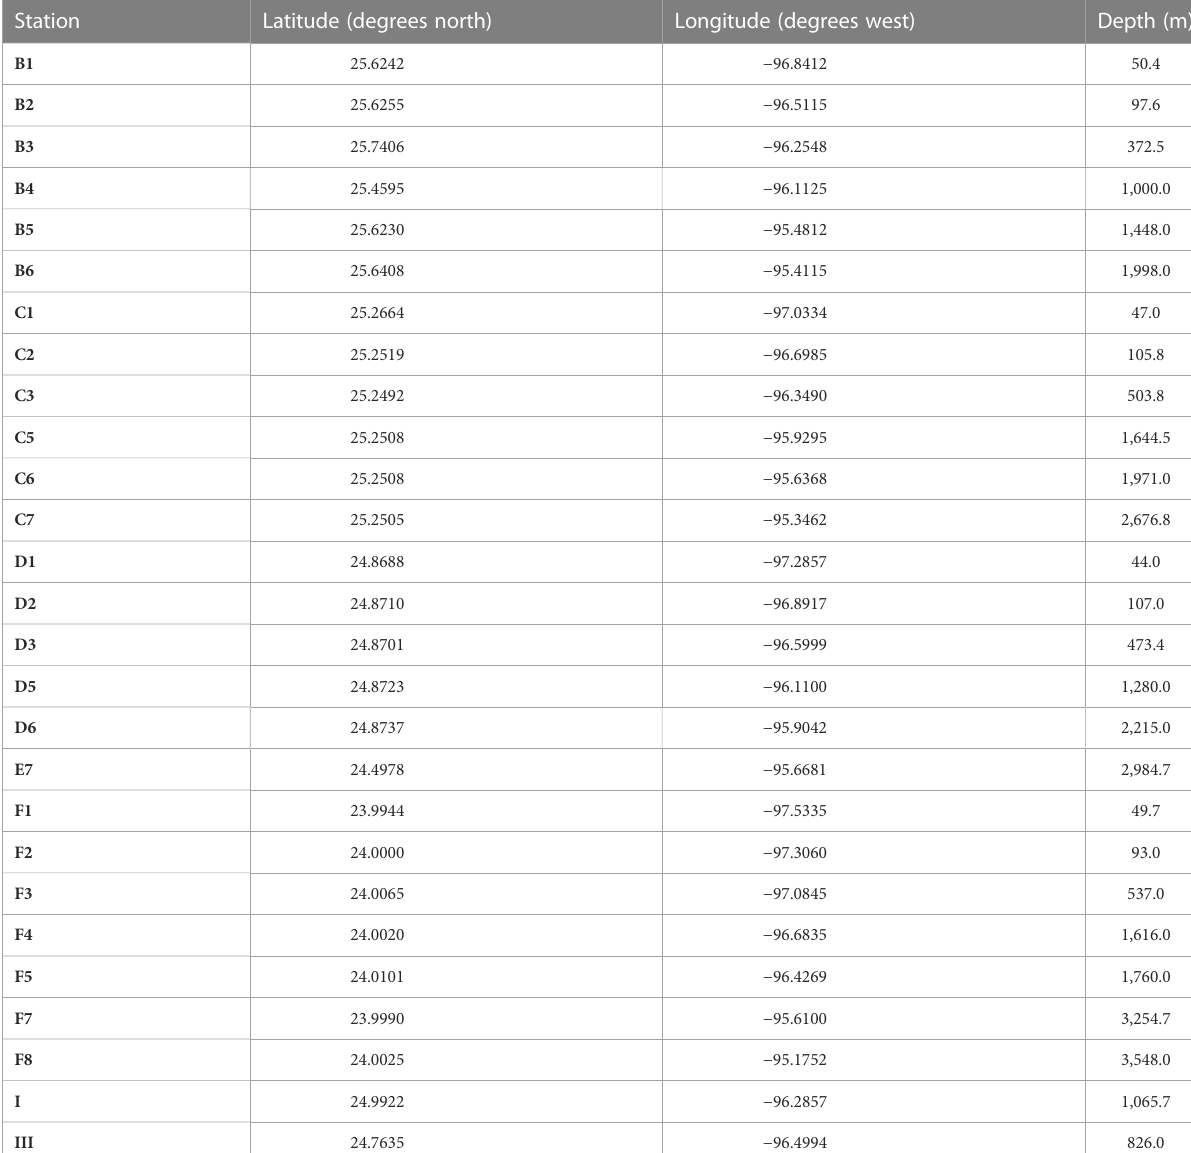
TABLE 1 Sampling stations for all four cruises.